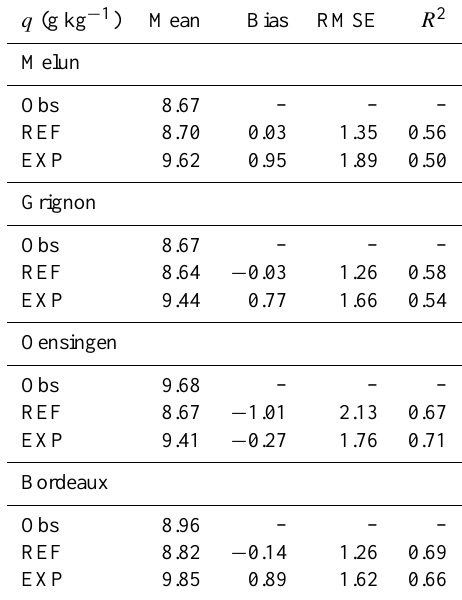
Table 3. Statistics of the 2m specific humidity for the entire month of June